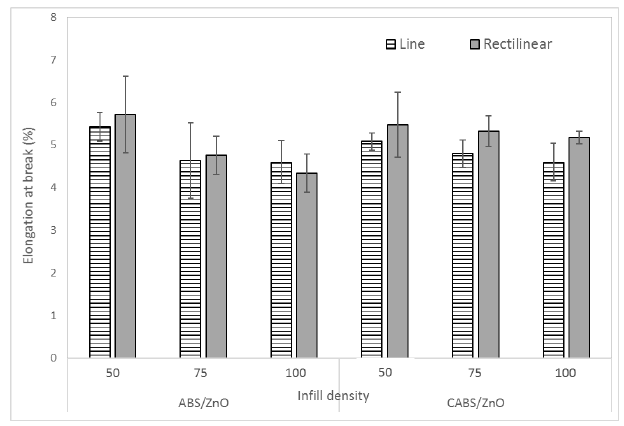
Figure 7. Effect of infill density and printing pattern on elongation at break of ABS/ZnO and CABS/ZnO samples.